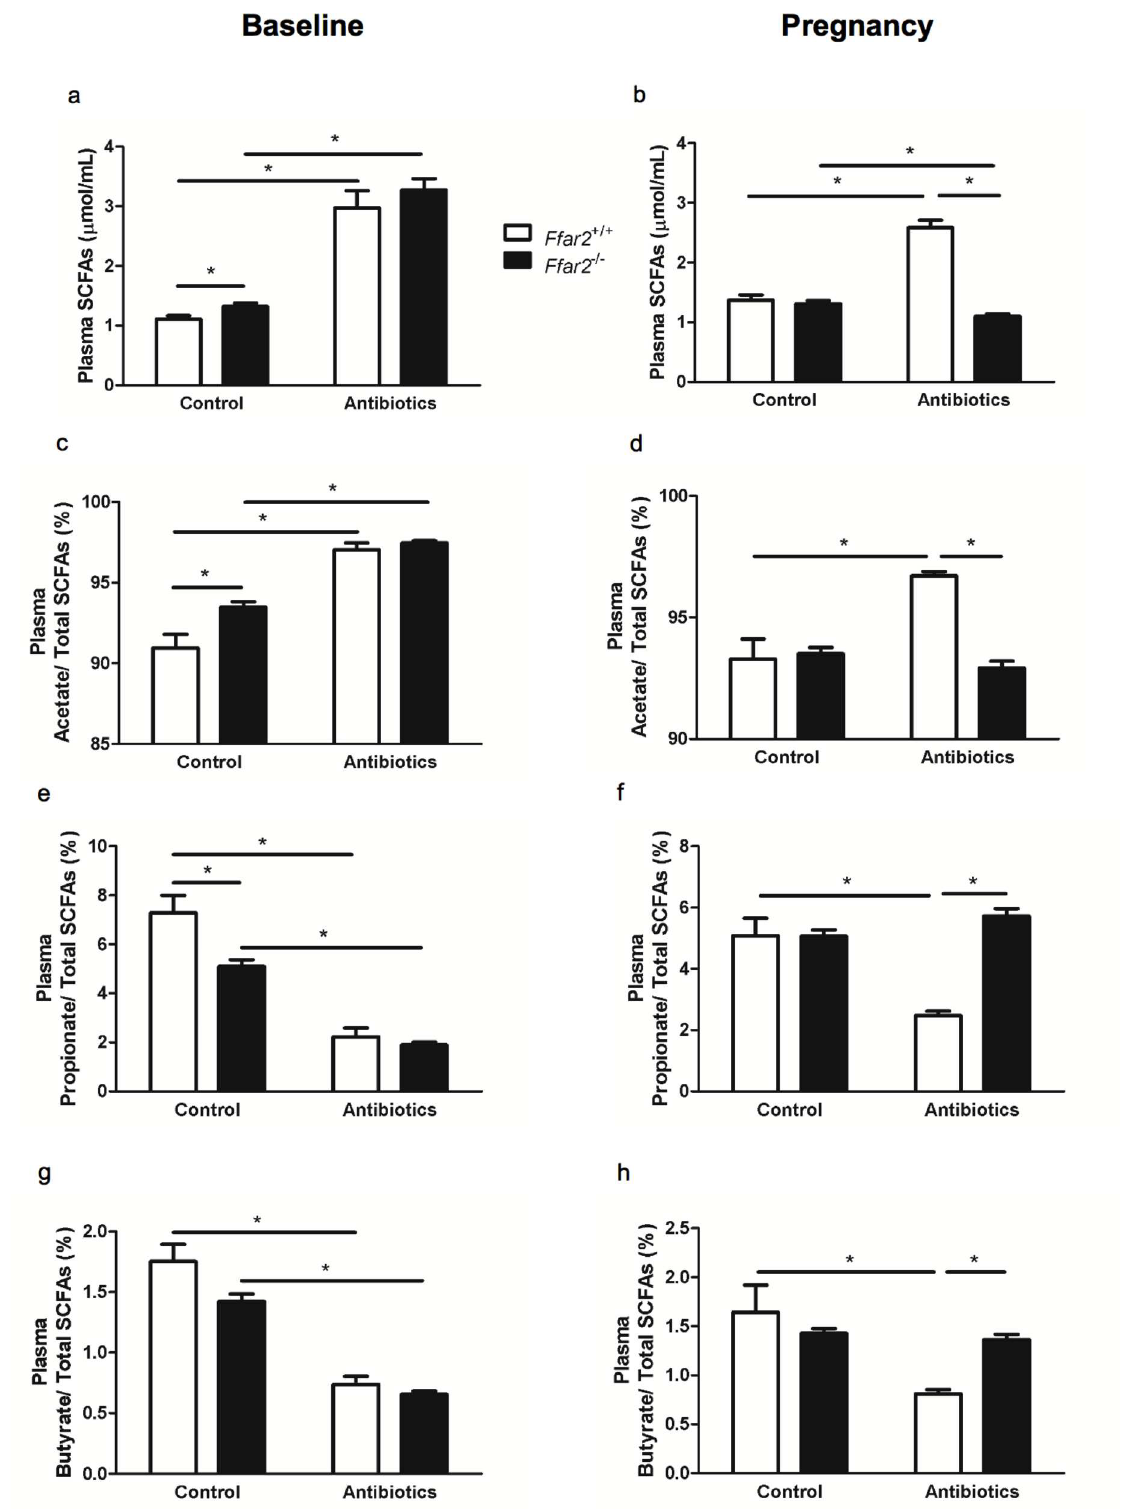
Fig 6. Antibiotics alter the relative abundance of individual SCFAs in circulation during pregnancy. Total plasma SCFA levels which includesacetate, propionate,and butyrate measuredin WT and Ffar2 -/- mice at G0 (a) and G15 (b) under control vs antibiotic-treated conditions. ( b-h ) Relativeabundance of individualSCFAs (acetate, c-d ; propionate, e-f ; and butyrate, g-h )